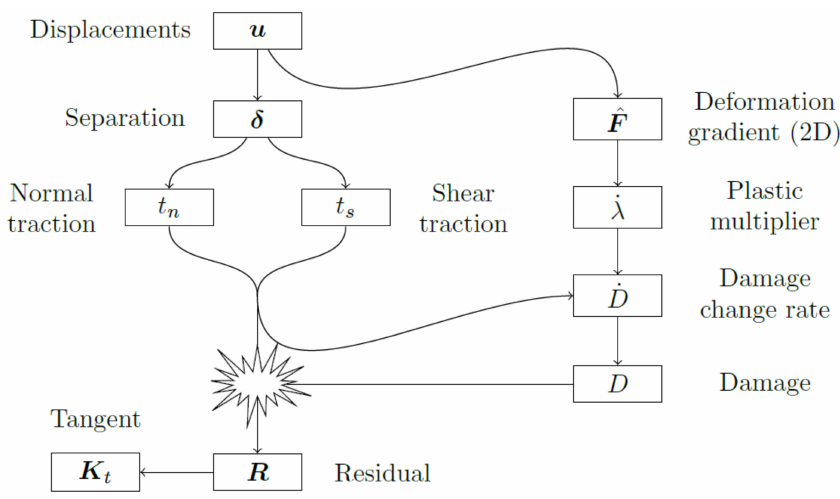
Figure 4. Merging cohesive zone modes and membrane modes [5].